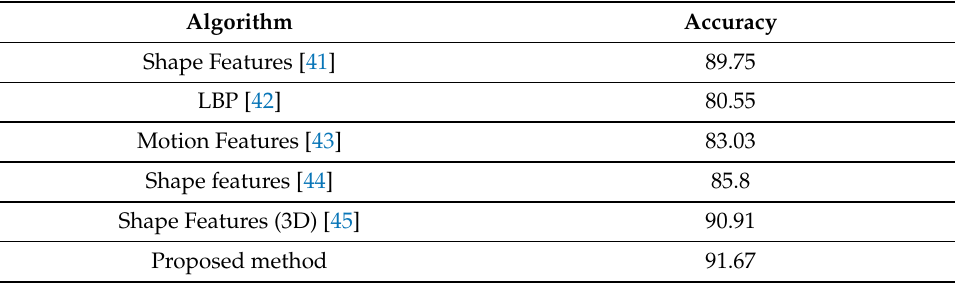
Table 7. Multi-view HAR on IXMAS